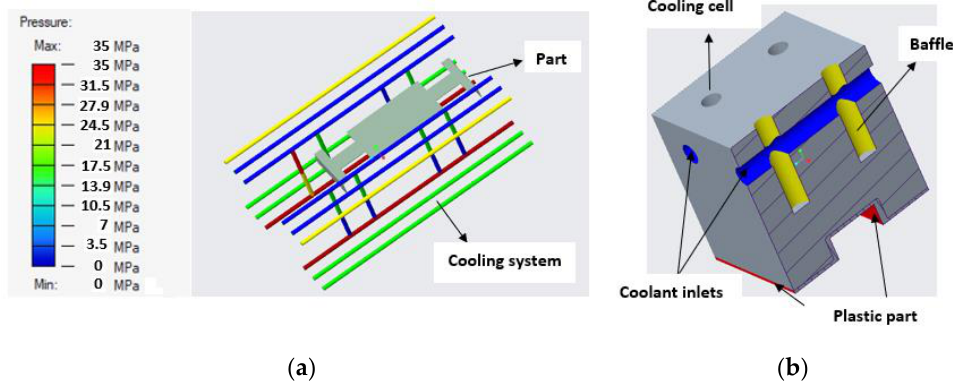
Figure 4. ( a ) Pressure field and temperatures in a refrigeration system. ( b ) Cooling system by means of baffles.